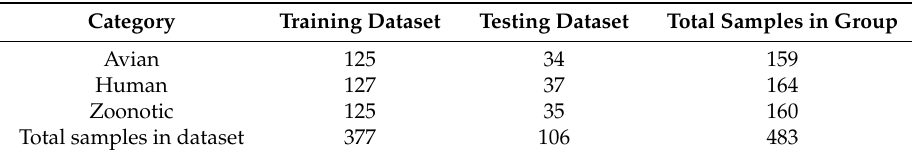
Table 3. Final dataset of avian, human and zoonotic strains for construction of the zoonotic strain prediction